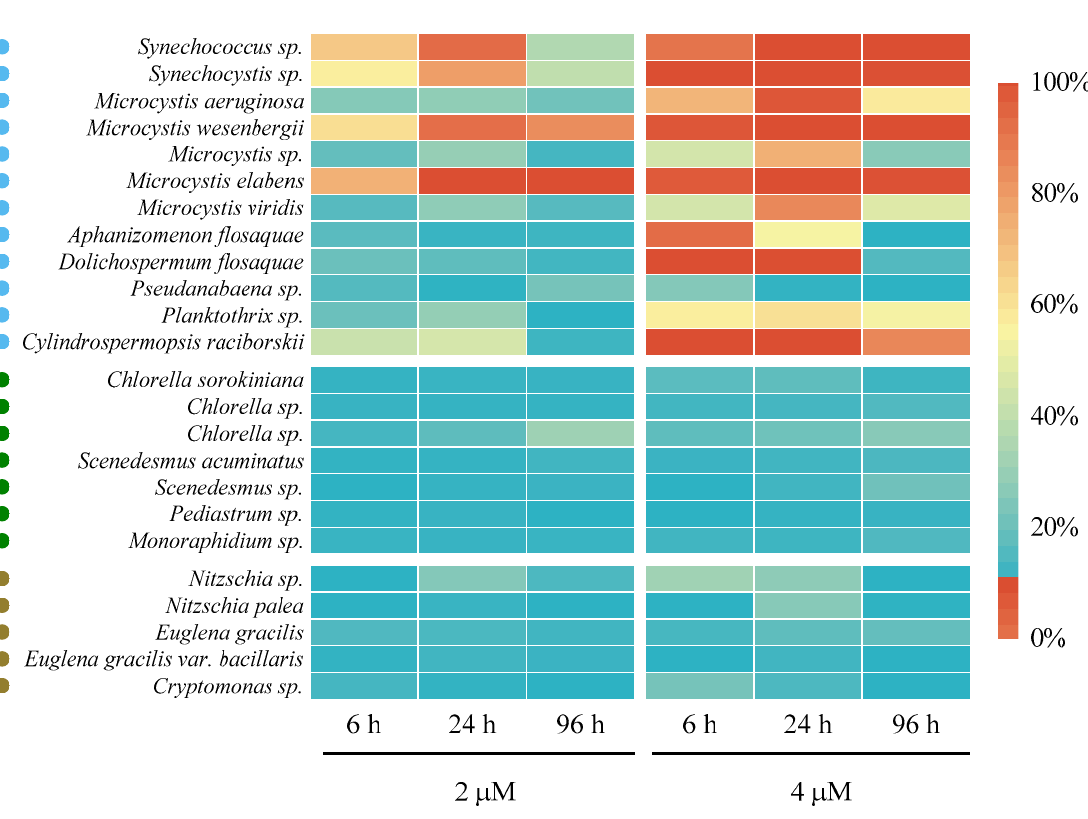
Figure 2. A heatmap presenting algaecidal spectrum and selectivity of ODTMA-Br (C18) at 2 and 4 µ M. The inhibition ratio was calculated by the decrease in Fv/Fm value relative to control. A total of 24 cyanobacteria and eukaryotic algae, covering 12 Cyanobacteria (marked in blue cycles), 7 Chlorophyta (marked in green cycles) and 5 other eukaryotic algae (marked in brown cycles, including 2 Bacillariophyta, 2 Euglenozoa and 1 Cryptophyta) were used.